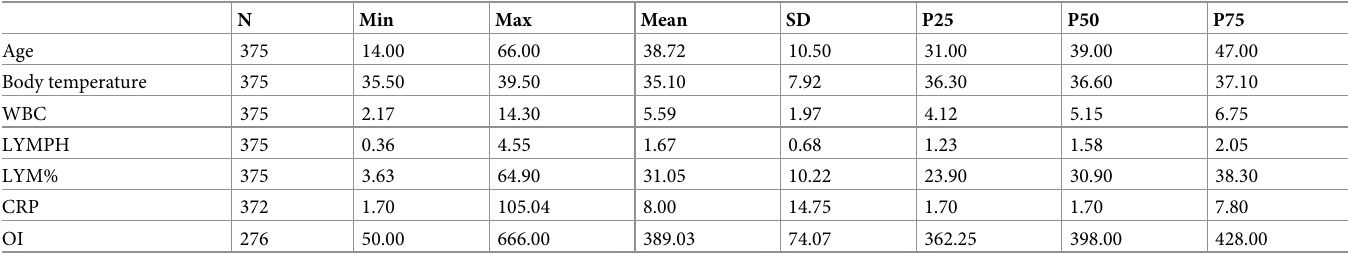
Table 2. Demographic and clinical data of imported COVID-19 cases from Russia through the Suifenhe port.